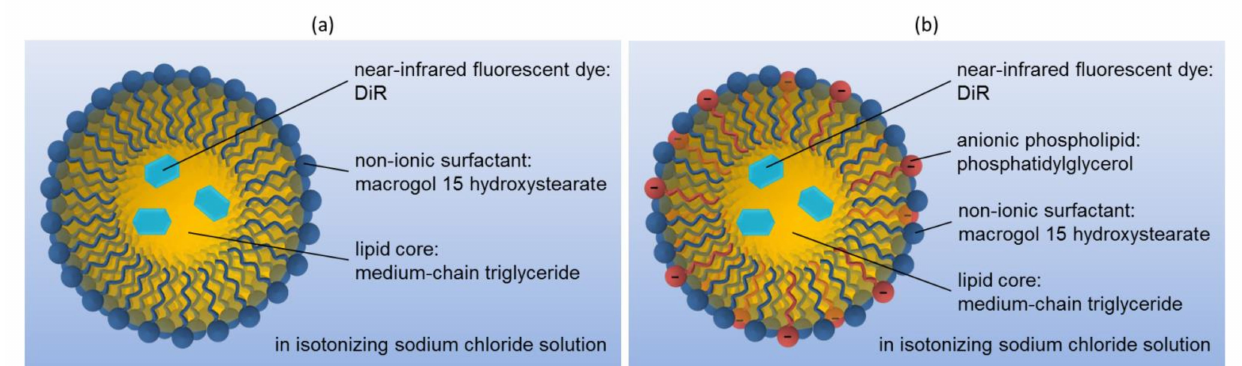
Figure 1. Composition of the nanoemulsions for the in vivo biodistribution studies: ( a ) previously in vivo investigated neutral surface-charged nanoemulsions [24] and ( b ) surface modified negatively surface-charged nanoemulsions through the integration of the anionic phospholipid PG into the stabilizing